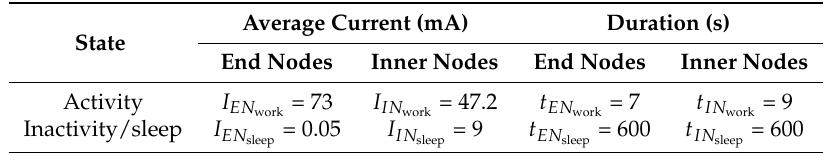
Table 6. Experimental results on mean current consumption and time duration of platform nodes during their operational phases (activity and